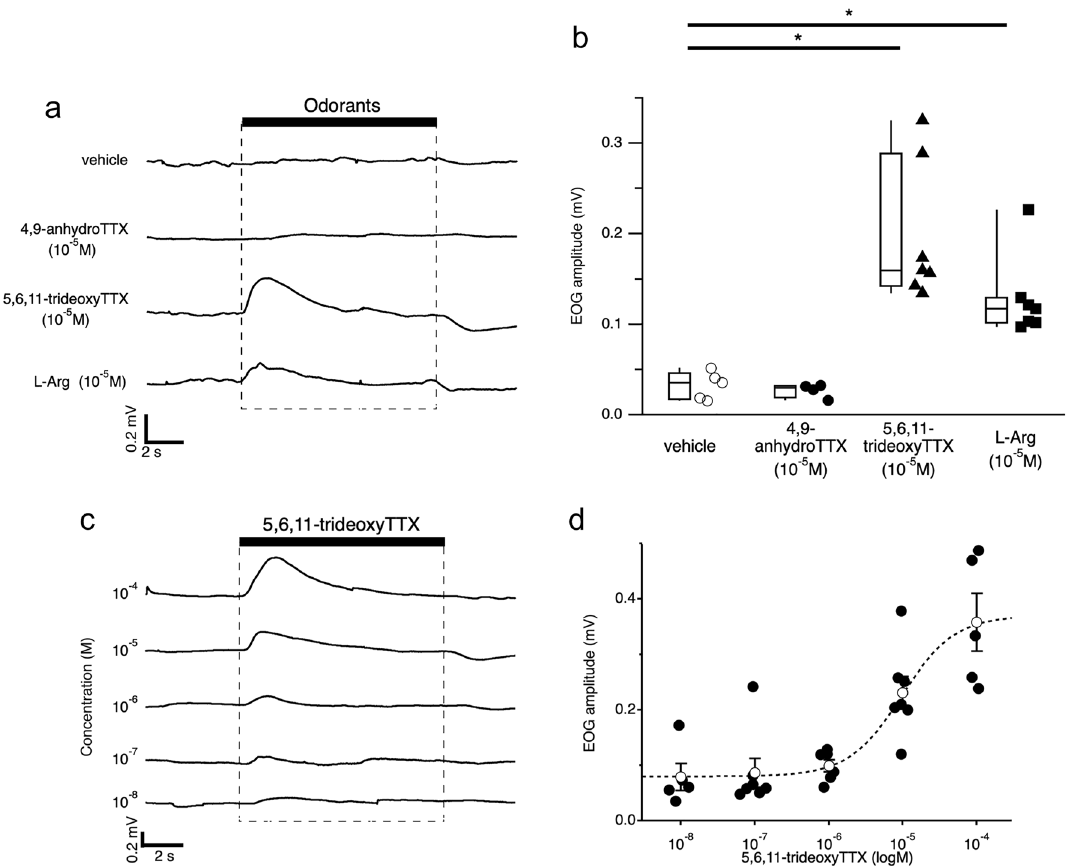
Figure 3. 5,6,11-trideoxyTTX induced EOG response of the grass puffer. ( a ) EOG responses to vehicle (top trace), 4,9-anhydroTTX (10 –5 M, second trace), 5,6,11-trideoxyTTX (10 –5 M, third trace), and l-Arg (10 –5 M, bottom trace) from same grass puffer. ( b ) EOG amplitudes of vehicle (n = 5, open circles), 4,9-anhydroTTX (n = 4, filled circles), 5,6,11-trideoxyTTX (n = 7, filled triangles), and l-Arg (n = 7, filled square). Box plots show the median, quartiles (boxes), and 10%–90% range (whiskers) of EOG amplitudes, and dot plots show the raw value of EOG amplitudes. Steel’s multiple comparison test compared with vehicle (5,6,11-trideoxyTTX, P = 0.012; l-Arg, P = 0.012): *p < 0.05. ( c ) Representative EOG responses by a grass puffer were evoked by increasing the concentration of 5,6,11-trideoxyTTX. The period of 5,6,11-trideoxyTTX administration is shown by the black bar. ( d ) Dose–response relationship of 5,6,11-trideoxyTTX obtained from n = 5–7 fish. Peak EOG responses are plotted as a function of the concentrations delivered. Black circles show the individual EOG amplitudes, and open circles show the mean EOG amplitude at given concentrations. Error bars represent the standard error. The dotted line represents a Hill equation fitted to the data (EC 50 : 9.62 × 10 –6 M, Hill coefficient: